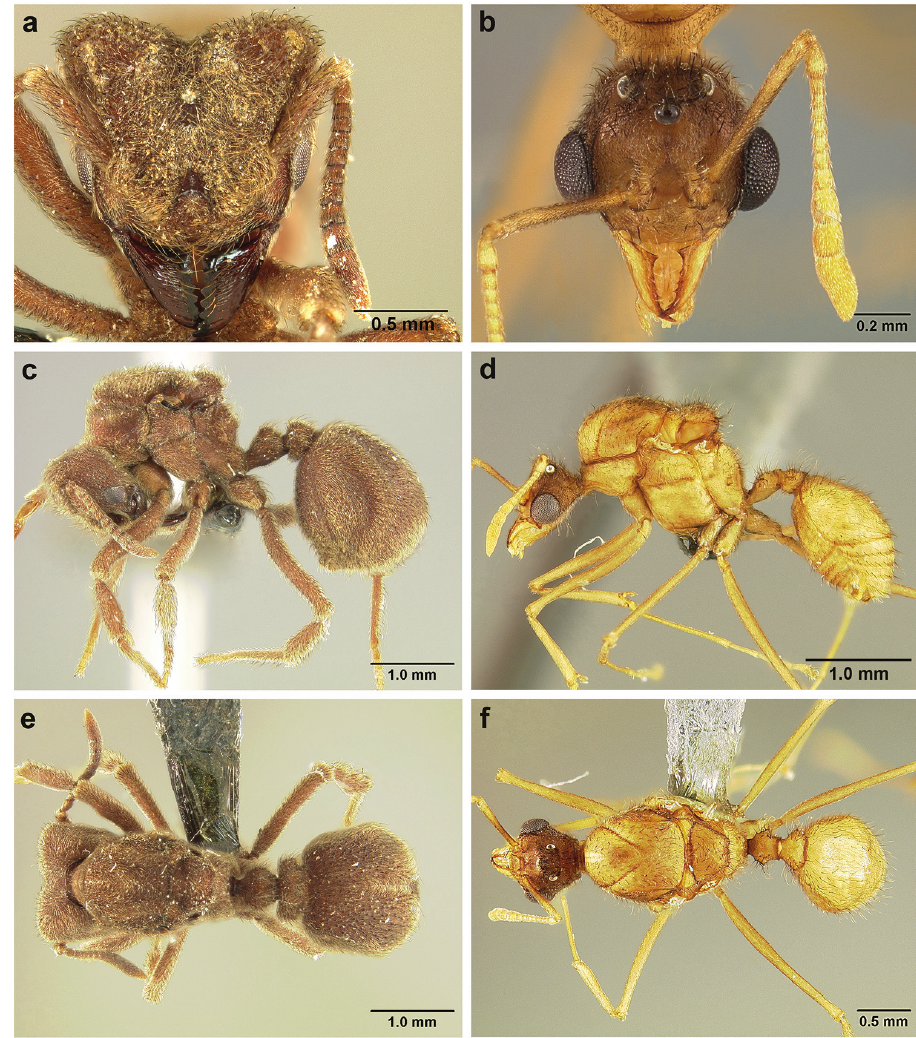
Figure 19. S. amabilis queen and male; head, profile, and dorsal view. Queen (USNMENT01125871) ( a, c, e ) Male (USNMENT01125846) ( b, d, f